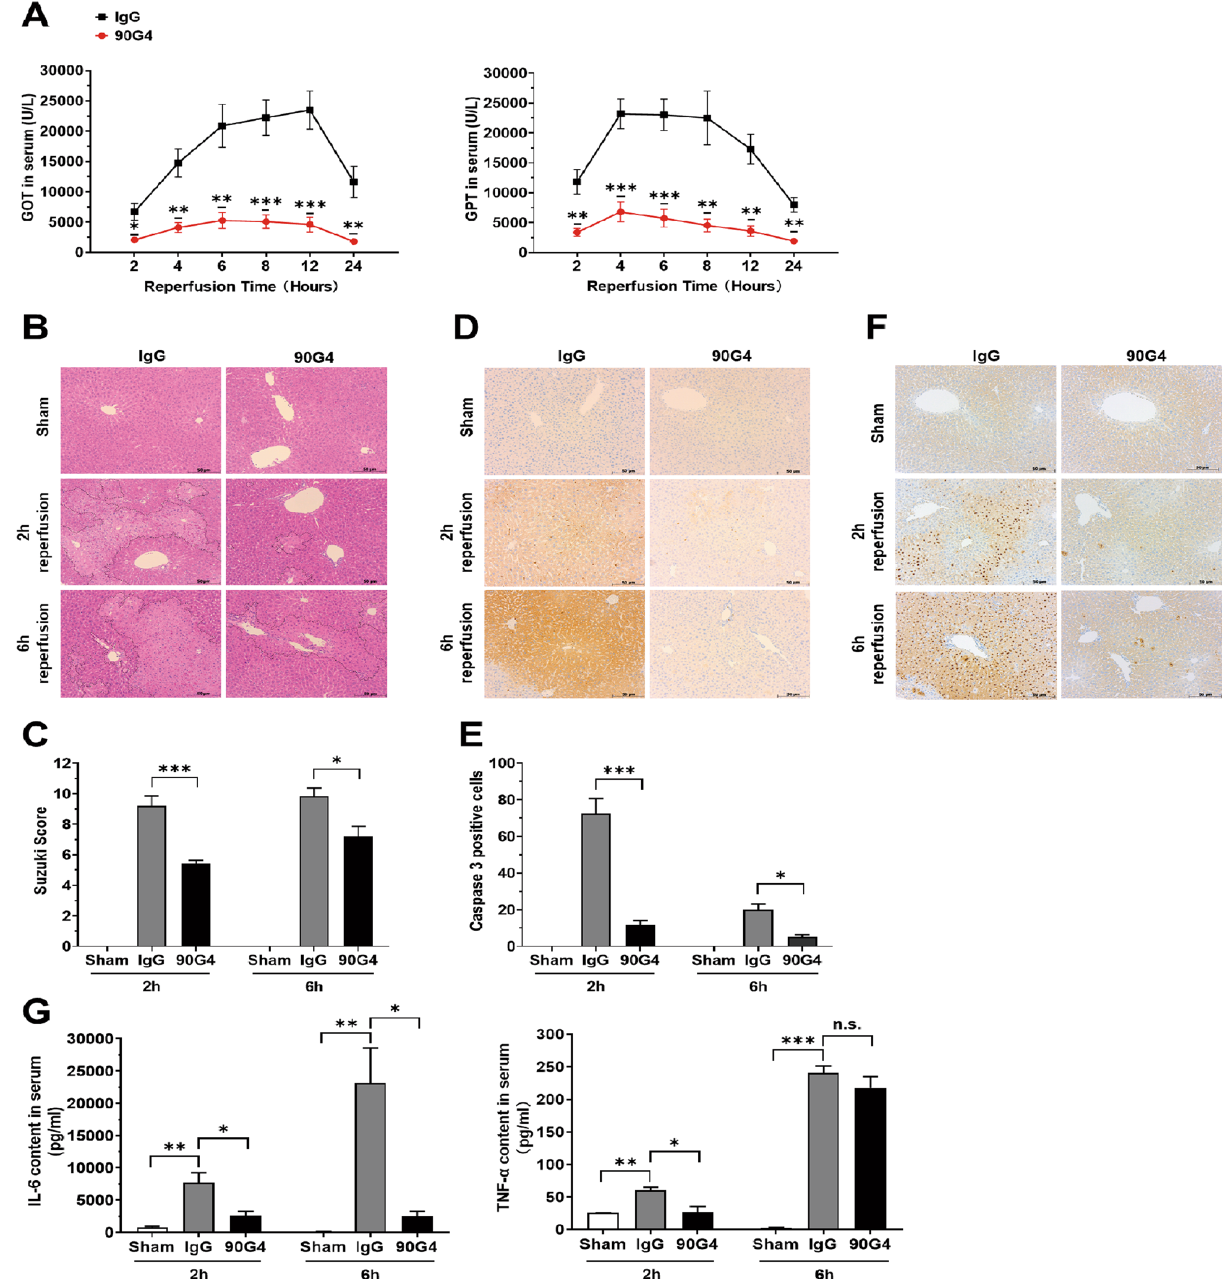
Figure 4. Anti-CD321 mAb (90G4) treatment inhibits hepatic IRI. (A) Serum GOT and GPT levels in 90G4-tretaed hepatic IRI mice. Sera were collected at the indicated time after the reperfusion from the hepatic IRI mice treated with 90G4 or rat IgG, then serum GOT and GPT levels were examined (n = 5–7 in each group). (B) Representative images of hematoxylin and eosin staining of damaged livers from indicated antibody-treated mice at indicated times after reperfusion. Necrotic areas are surrounded by dashed lines. (C) Histologic injury score of hematoxylin and eosin staining sections analyzed by Suzuki criteria (n = 3 mice in sham group and n = 5–6 mice in IRI group). (D) Representative images of Caspase-3 staining of livers at the indicated time after reperfusion of the indicated antibody-treated mice. (E) Caspase-3 positive cells (dark brown spots in Figure D ) were counted and analyzed using Image J software (n = 3 mice in sham group and n = 5–6 mice in IRI group). (F) Representative images of TUNEL staining of ischemic livers at the indicated time after the reperfusion of the indicated antibody-treated mice (n = 3 in each group). (G) Serum IL-6 and TNF- α levels. Sear was collected from the sham-operated mice and IRI mice treated with indicated mAb at 2 and 6 h after the reperfusion. The amount of IL-6 and TNF- α was measured by ELISA (n = 3 mice in sham group and 5–6 mice in IRI group). *P < 0.05, **P < 0.01, ***P < 0.001. Results are presented as Mean ± SEM ( C , E , G ). Magnification, × 20 ( B , D , F ). N = 2–3 independent